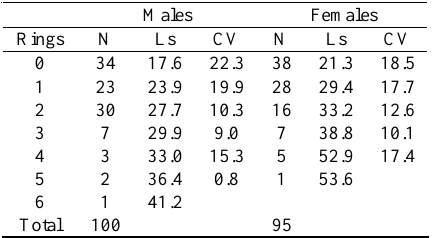
equate to estimate